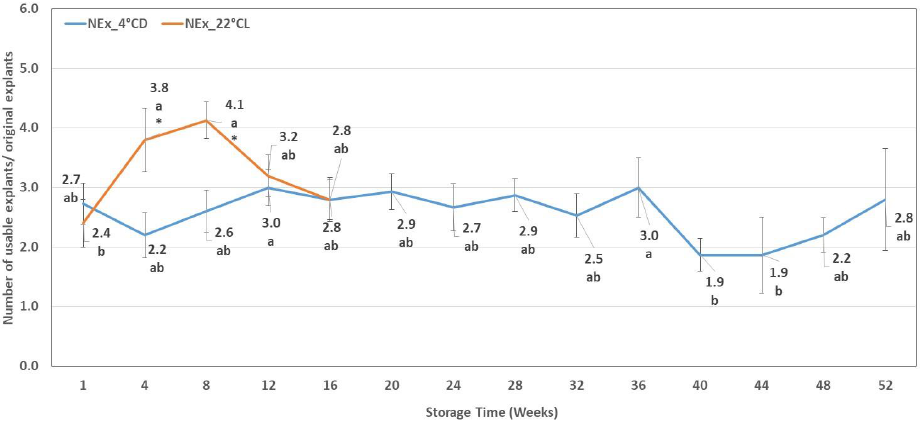
Figure 6. The number of usable explants after different periods of cold storage (NEx_4 °CD) and of storage in the growth chamber (NEx _22 °CL). Line graphs present mean values ± SE of the number of usable explants. Lower case indicates the significant differences between the number of usable explants counted after different storage times. * indicates the significant differences between the number of usable explants after different storage conditions.